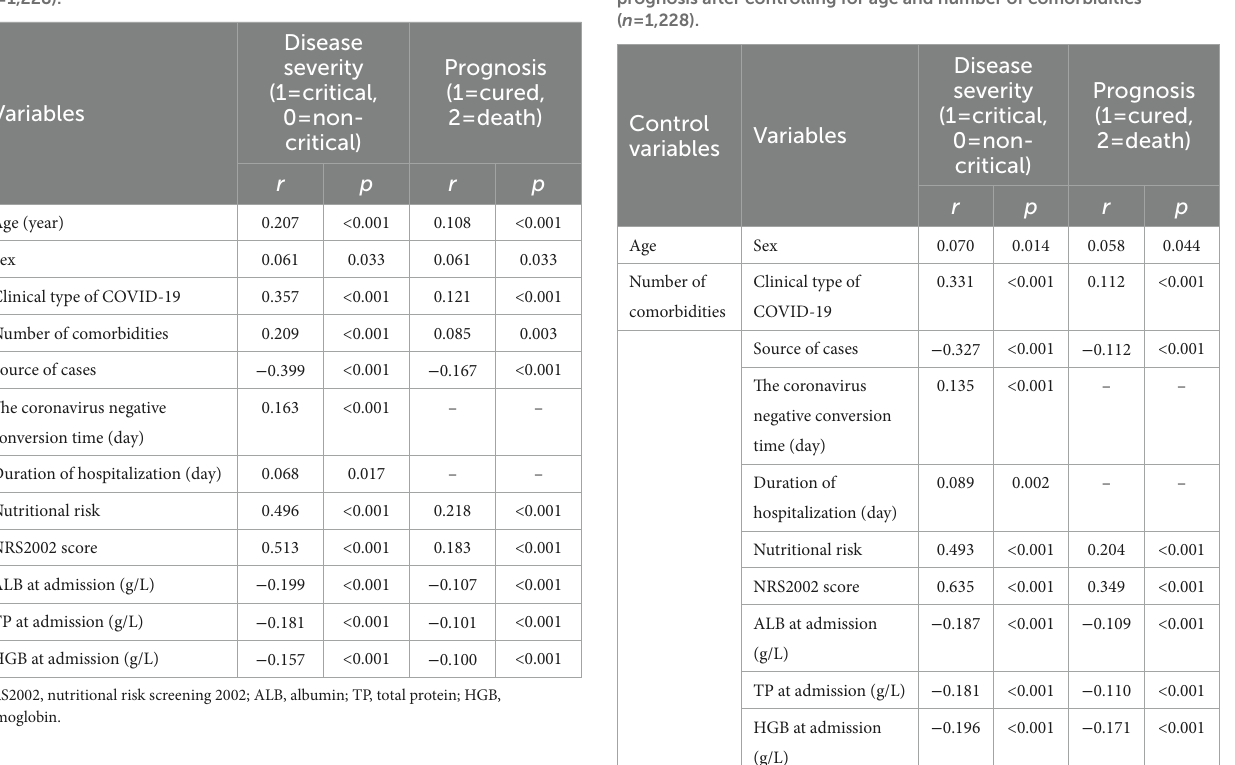
TABLE 3 Spearman correlation analysis between nutritional parameters, nutritional risk, NRS2002 score and the disease severity and prognosis ( n = 1,228).